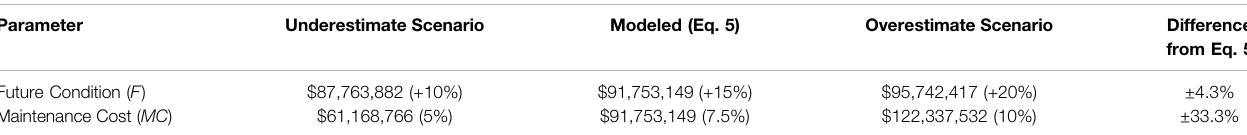
TABLE 1 | Sensitivity analysis of 2050 projections of Louisiana statewide annual property loss (i.e., risk) due to expansive soil, by parameter (2010$).